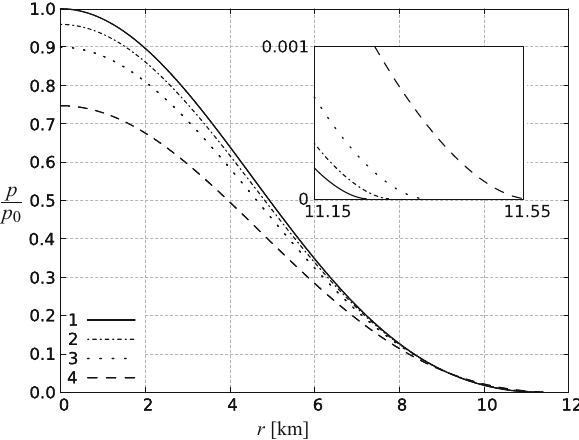
r [km] Fig. 2 Pressure profile for compact objects with LQG-inspired cor- rections and polytropic equation of state with k = 7 . 454 × 10 − 3 and γ = 2 . 5. The central density is chosen as ρ = 1 . 65 × 10 15 g / cm 3 and 0 critical densities are the same as in Fig. 1. See Table 1 for